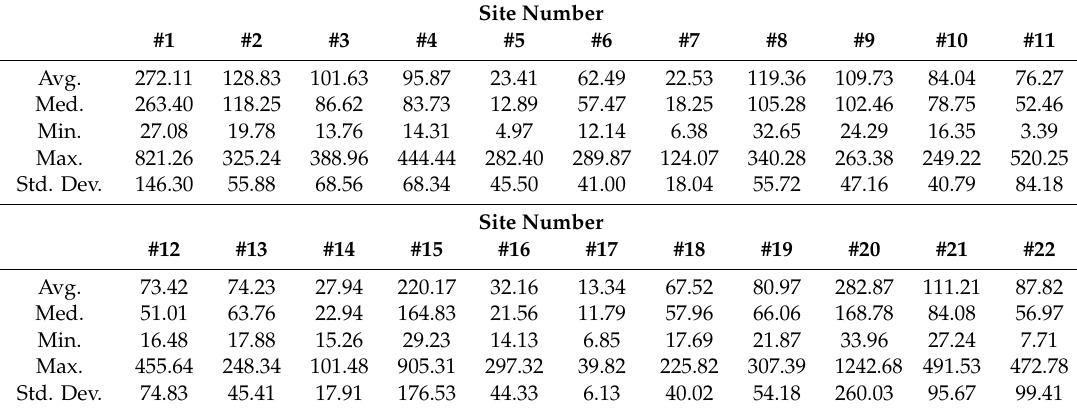
Table A6. Descriptive statistics of chloride ion (mg / L) at each sampling location (n = 22) during study period (2 January 2018–1 January 2019) in West Run Watershed, WV, USA. Avg. = average, Med = median, Min. = minimum, Max. = maximum and Std. Dev. = standard